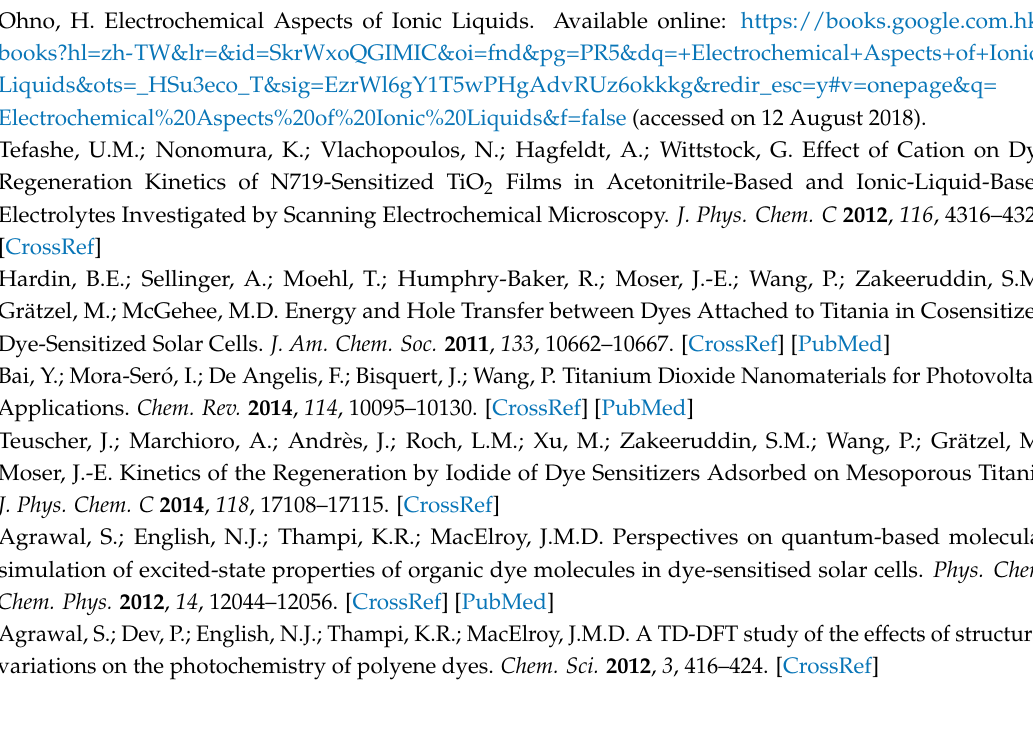
Figure S1: Snapshots of a typical trajectory showing some lowest energy structures of PBE system II. Atom labeling can be seen from figure 1. Figure S2: Snapshots of a typical trajectory showing some lowest energy structures of BLYP system II. Atom labeling can be seen from figure 1. Figure S3: Energy conservation graph of BLYP system II (top) and PBE system II (bottom). Figure S4: Snapshots of a typical trajectory showing with I-[bmim]+. Carbon is shown in cyan, nitrogen in blue, oxygen in red, hydrogen in white, titanium in light pink, sulphur in yellow, ruthenium in light cyan surrounded by nitrogen’s and Iodine in purple. Ionic liquid(bmim) shown in wired form for ease of